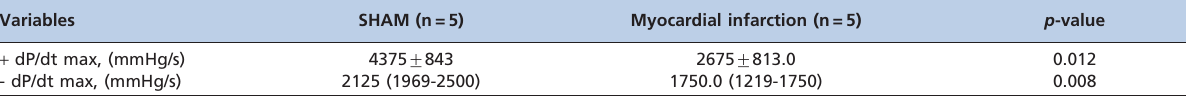
Table 3 - Morphometric data and myocardial hydroxyproline concentration.